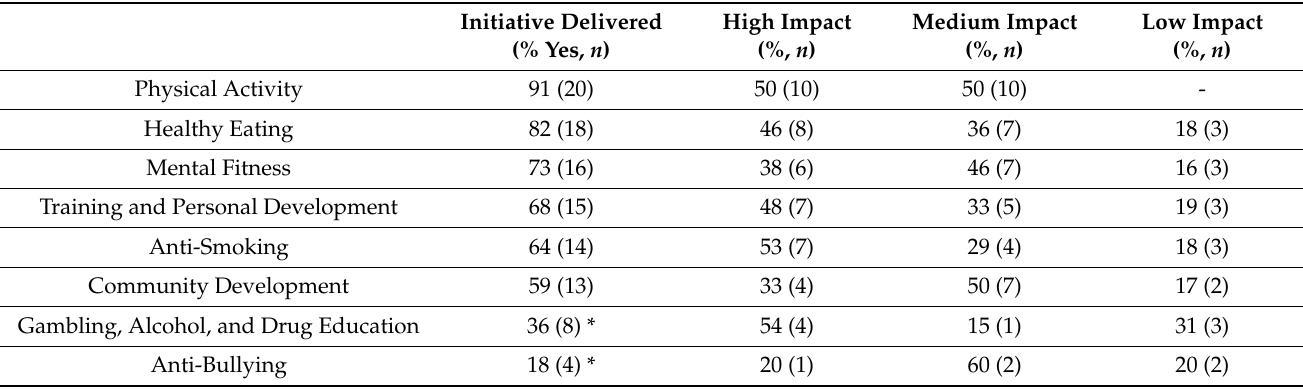
Table 4. Delivery and impact of HCP